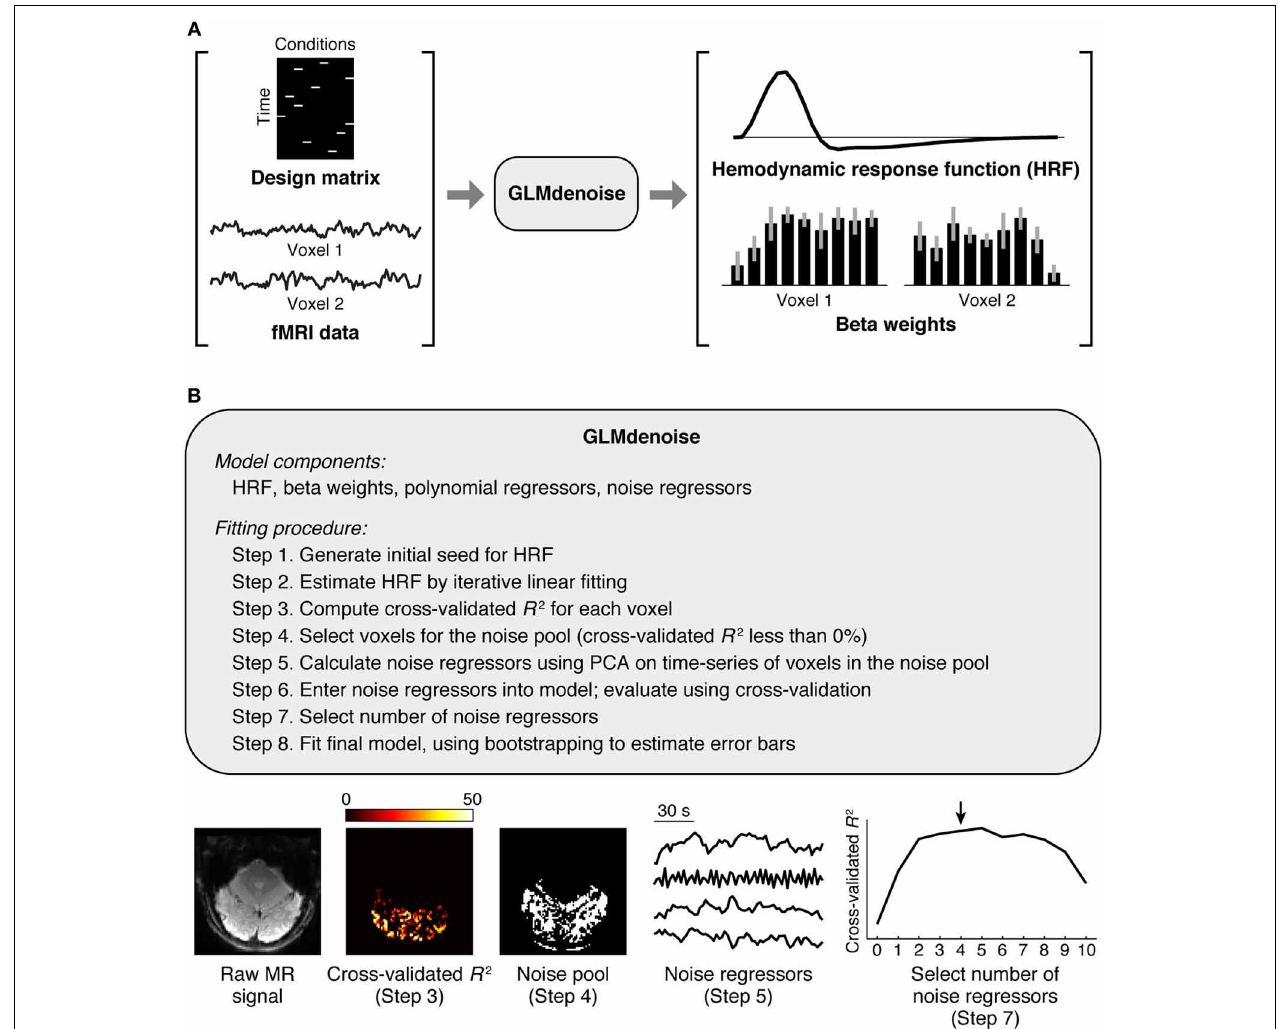
FIGURE 1 | Schematic of GLMdenoise. (A) Inputs and outputs. GLMdenoise takes as input a design matrix (where each column indicates the onsets of a given condition) and fMRI time-series, and returns as output an estimate of the hemodynamic response function (HRF) and BOLD response amplitudes (beta weights). (B) Fitting